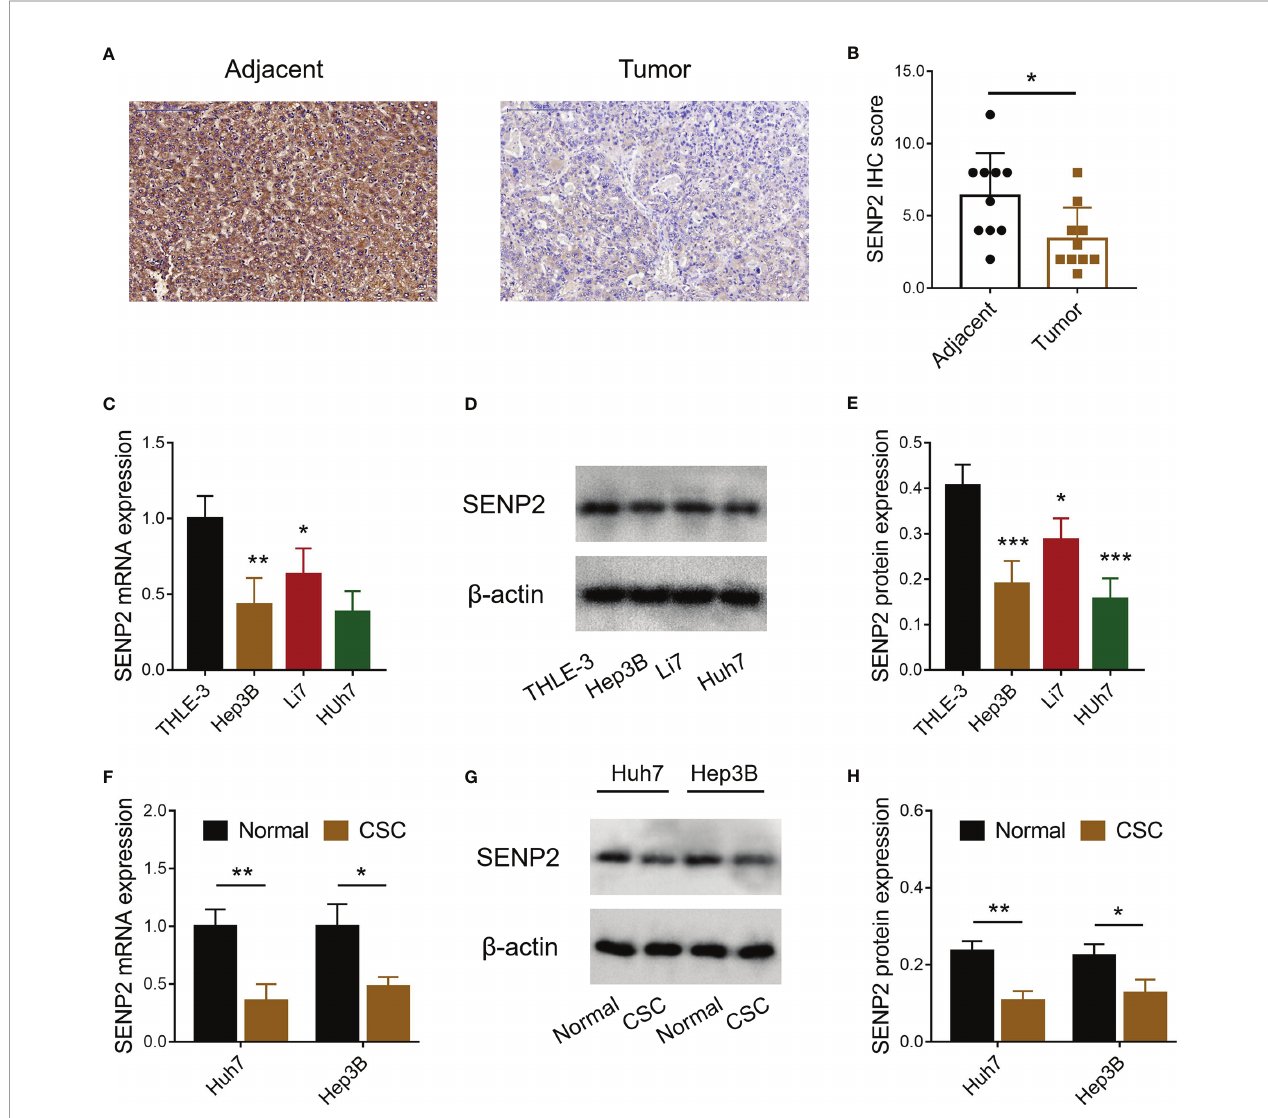
FIGURE 1 | Detection of SENP2 expression. Representative images of SENP2 expression detection by IHC assay in HCC tumor and adjacent tissues (A) . Comparison of SENP2 IHC score between HCC tumor and adjacent tissues (B) . Comparison of SENP2 mRNA expression among the THLE-3 cell line and HCC cell lines (C) . Detection of SENP2 protein expression by Western blot in the THLE-3 cell line and HCC cell lines (D) . Comparison of SENP2 protein expression among the THLE-3 cell line and HCC cell lines (E) . Comparison of SENP2 mRNA expression between normal HCC cells and HCC CSCs (F) . Detection of SENP2 protein expression by Western blot in normal HCC cells and HCC CSCs (G) . Comparison of SENP2 protein expression between normal HCC cells and CSCs of HCC CSCs (H) . SENP2, Small ubiquitin-like modi fi er speci fi c peptidase 2; IHC, immunohistochemical; HCC, hepatocellular carcinoma; CSC, cancer stem cell; * p < 0.05; ** p < 0.01; *** p <